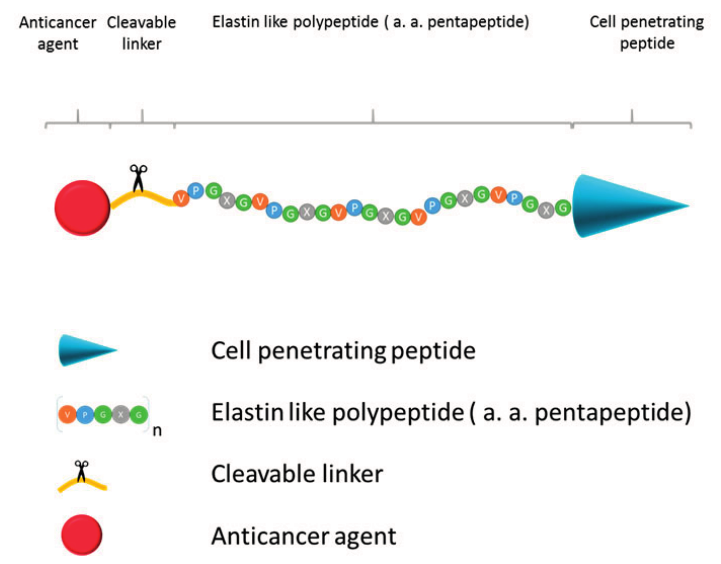
Figure 10. Schematic presentation of Elastin like polypeptide (ELP) polymeric prodrug. Construct consists of (1) Cell penetrating peptide, mediating uptake of ELP in tissues and cancer cells; (2) ELP, thermally responsive biopolymer which can be actively targeted to tumor tissue by external application of mild heat; (3) cleavable linker, releases anticancer agent in tumor tissues and cancer cells, and (4) anticancer